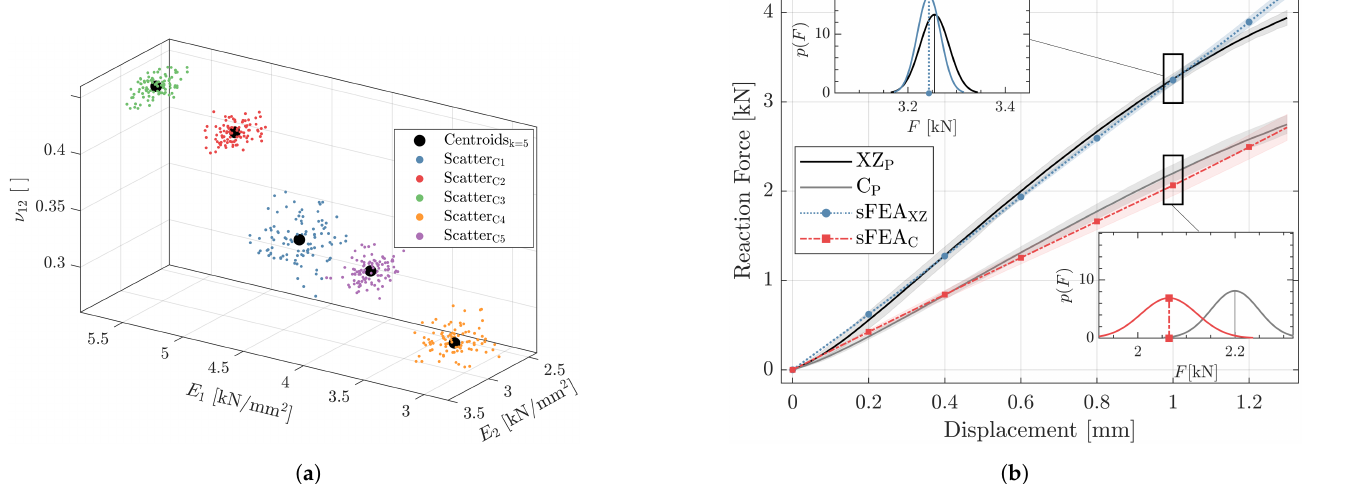
Figure 12. ( a ) Randomized material properties of the clustered ( k = 5) XZ P specimen and ( b ) load–displacement curves of the stochastic analysis compared to experimental results, where shaded areas indicate the 95% confidence interval around the mean